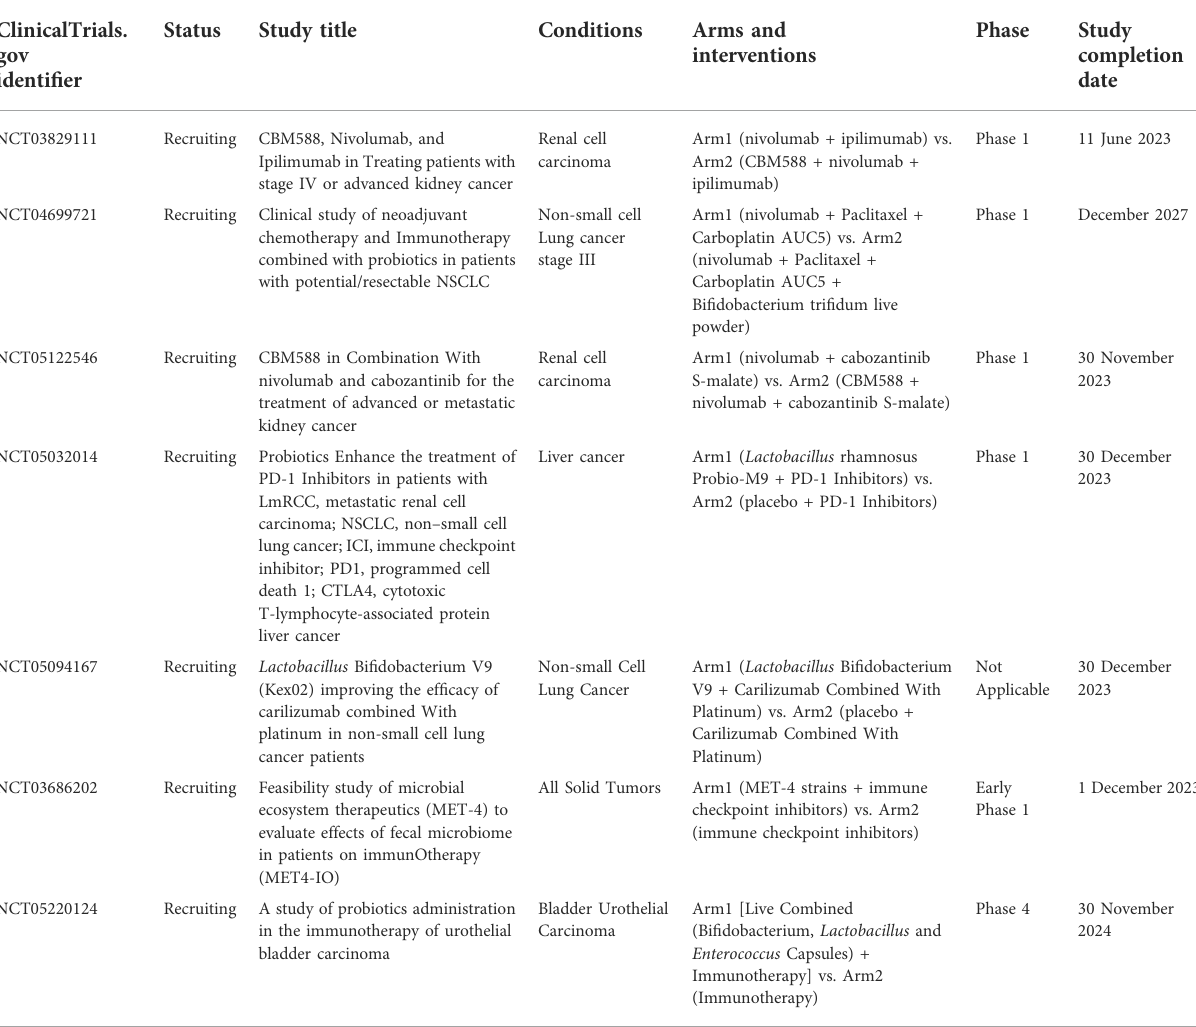
TABLE 2 Ongoing interventional clinical studies in cancer patients who have received/will receive ICI and probiotics. ClinicalTrials.